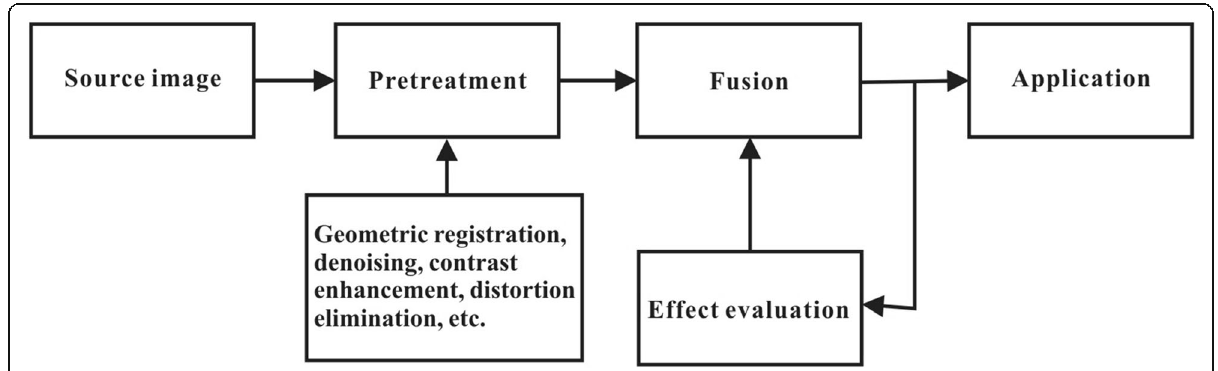
Fig. 1 Basic principle block diagram of pixel level